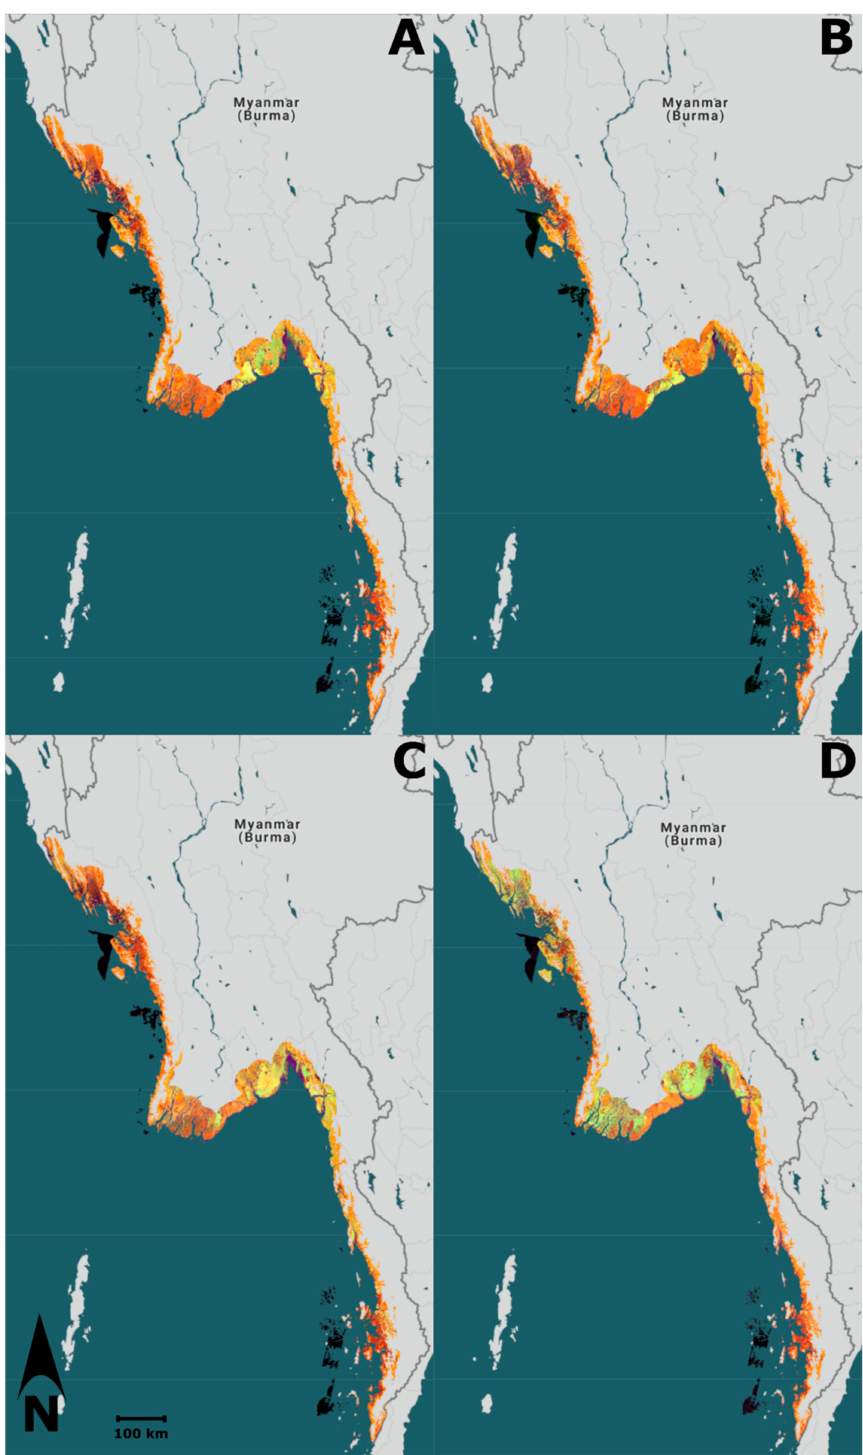
Figure 6. National overview of image composite outputs from the GEEMMM showing highest observable tide (HOT) and lowest observable tide (LOT) (false color composites, R: NIR, G: SWIR, B: Red). The composites were further reduced in area using topographic and combined water masks. ( A ) Contemporary HOT; ( B ) Contemporary LOT; ( C ) Historic HOT; ( D ) Historic